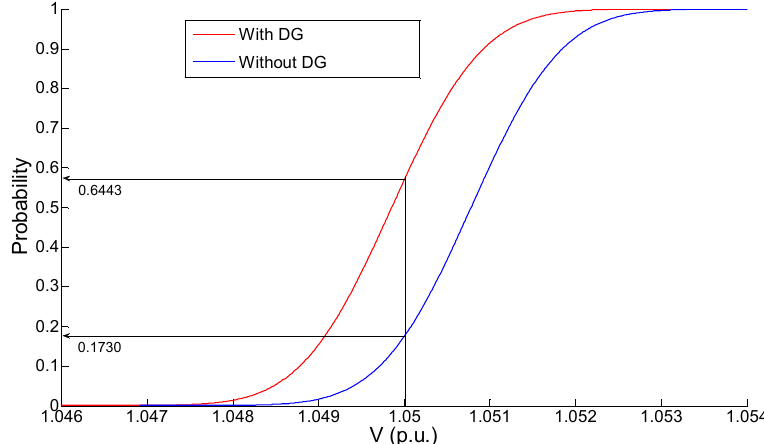
Figure 5. CDFs of voltage of bus 7 under normal state.